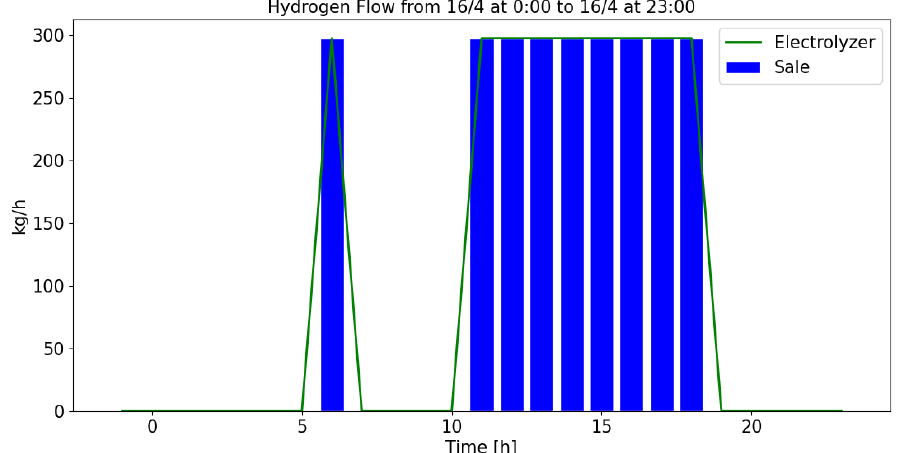
Figure 5. Hourly diagram of electrical power produced by PV, sold to the grid and used to supply electrolyser at the selling hydrogen price of 4.2 e /kg.